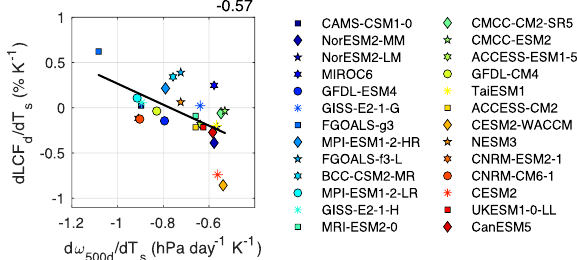
Fig. 4 | A greater decrease in low cloud fraction corresponds to a lesser reduction of subsidence with warming. The relationship between the change in subsidence rate (d ω 500d /dT s ; hPa day − 1 K − 1 ) and the change in descent region low cloudfraction(dLCF d /dT s ;%K − 1 )for26CMIP6models.Thecolorscalefromblueto redre fl ectsincreasingequilibriumclimatesensitivity(ECS)values.Allrelationships shown are tropical averages (30°S-30°N) including both land and ocean points. Changes are calculated as the differences between 2086 – 2100 (SSP5-8.5) and 2000 – 2014 (historical). The value in the upper right is the Pearson correlation coef fi cientfor the regression line shown. The relationship is statistically signi fi cant at the 95% con fi dence level ( p =